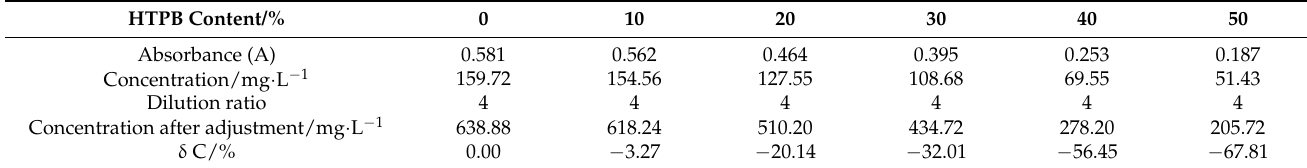
Table 8. Concentration of residual dye after the second